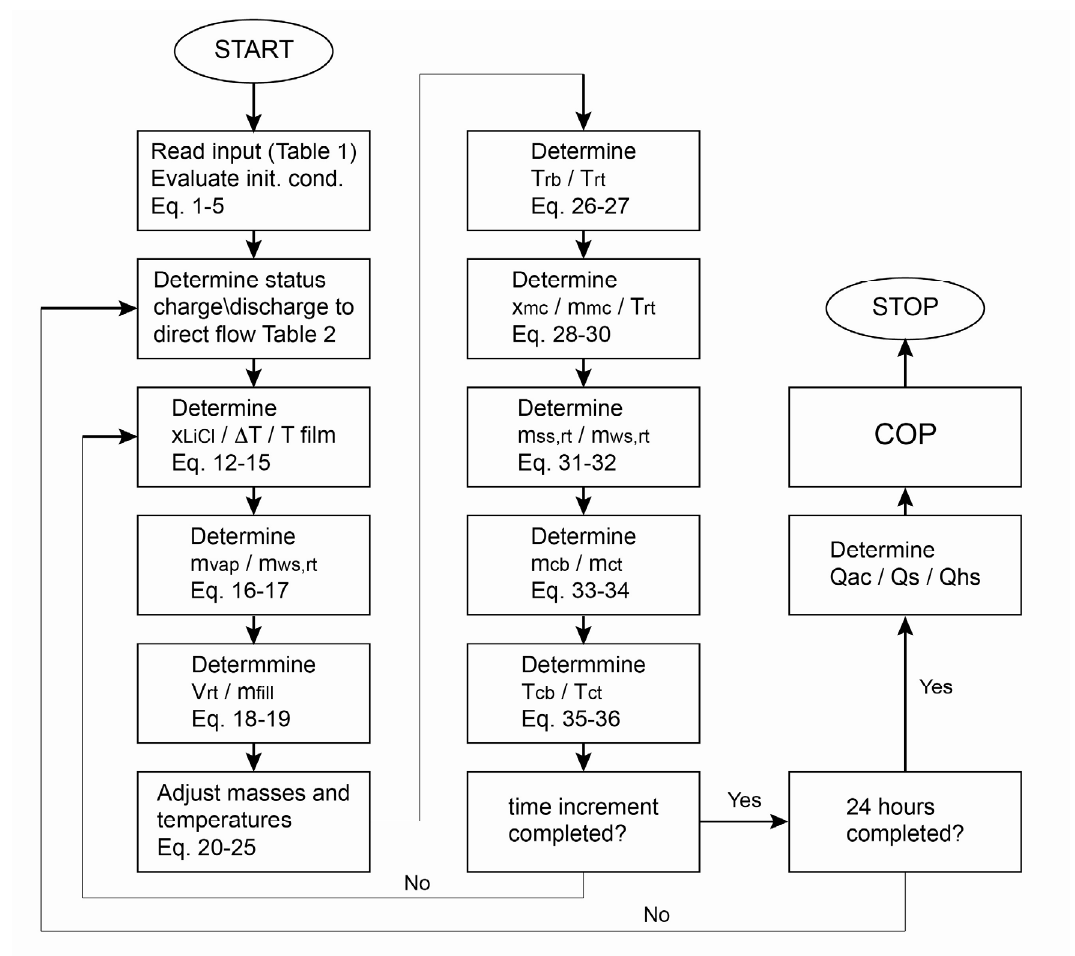
Figure 2. Program flowchart of the coefficient of performance (COP) evaluation